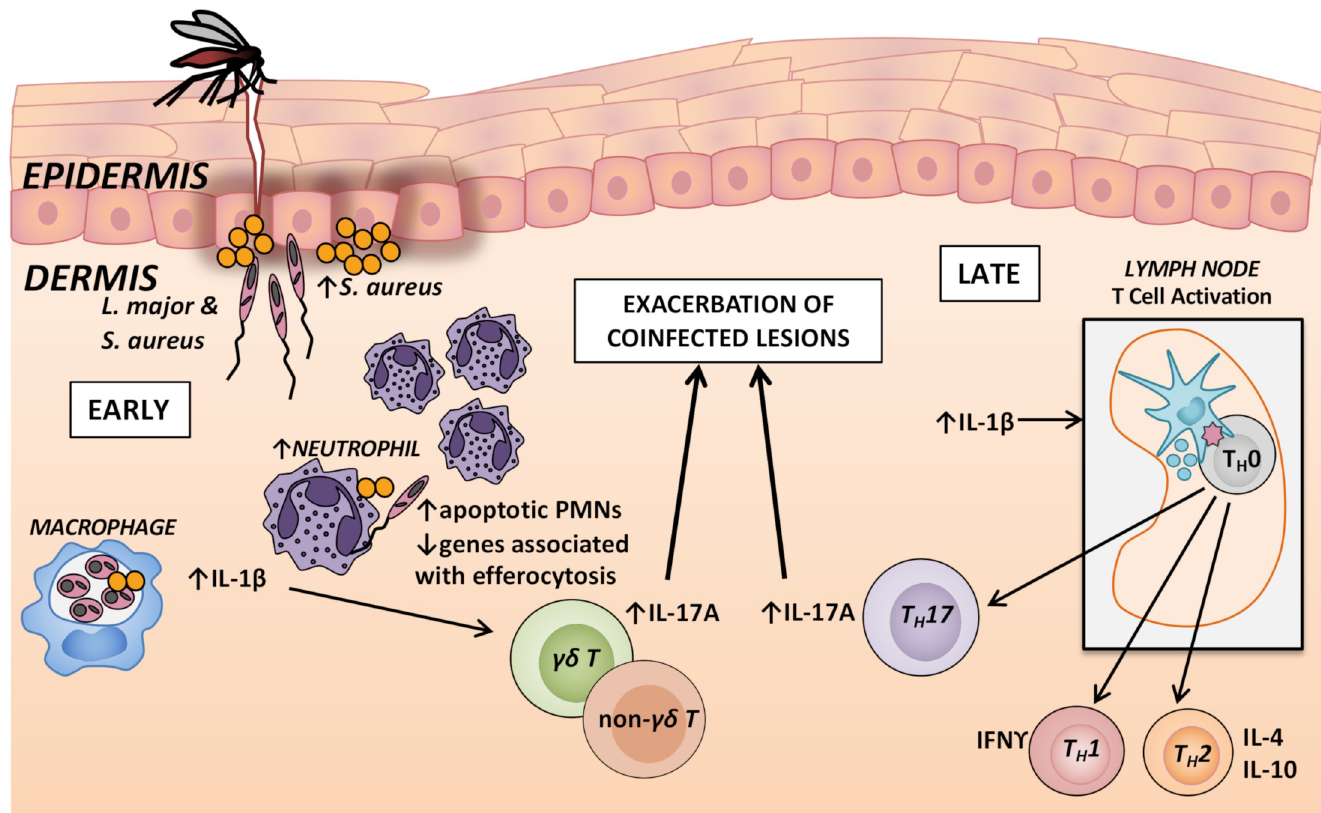
Fig 9. Proposed mechanism of L . major and S . aureus coinfection lesion exacerbation. When an infected sand fly takes a blood meal, it egests L . major into the skin, and S . aureus from the skin microbiota or from the sand fly gut also enters the skin. These organisms get taken up by host macrophages and neutrophils and promote the production of proinflammatory IL-1 β and IL-23 by myeloid cells. The presence of L . major allows for enhanced S . aureus growth during the early stages of infection. Although it is reported that IL-1 β and IL-23 promote the production of IL-17A from γδ and non- γδ T cells, and the differentiation of na ï ve T helper cells into Th17 cells, IL-1 β may have an important role in control of S . aureus growth and lesion pathology related to bacterial burden. Elevated IL-17A expression in correlated with more neutrophils at the coinfected lesion site that were mostly apoptotic in a setting of downregulated efferocytosis. The IL-17A pathway may be largely responsible for the exacerbation of coinfected